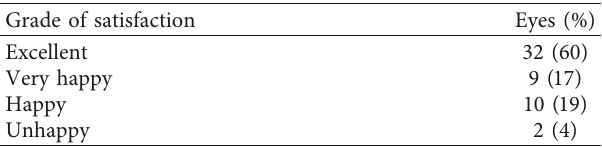
Supplementary Video 1: a video describes the technique of intrastromal corneal staining by Rotring painting Ink.